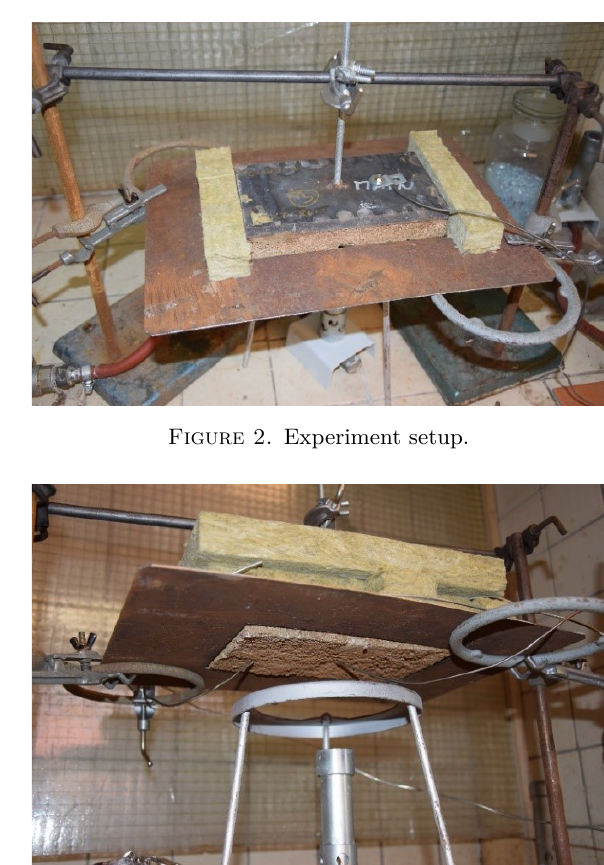
Figure 1. Comparison of regular (left) and careful (right) mixing of the mortar /the weight of both ele- ments is the same/.